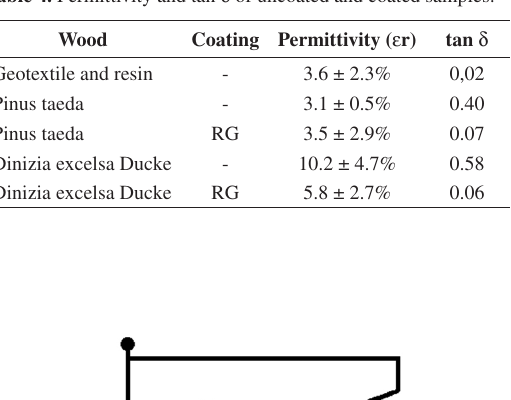
Table 4. Permittivity and tan δ of uncoated and coated samples.